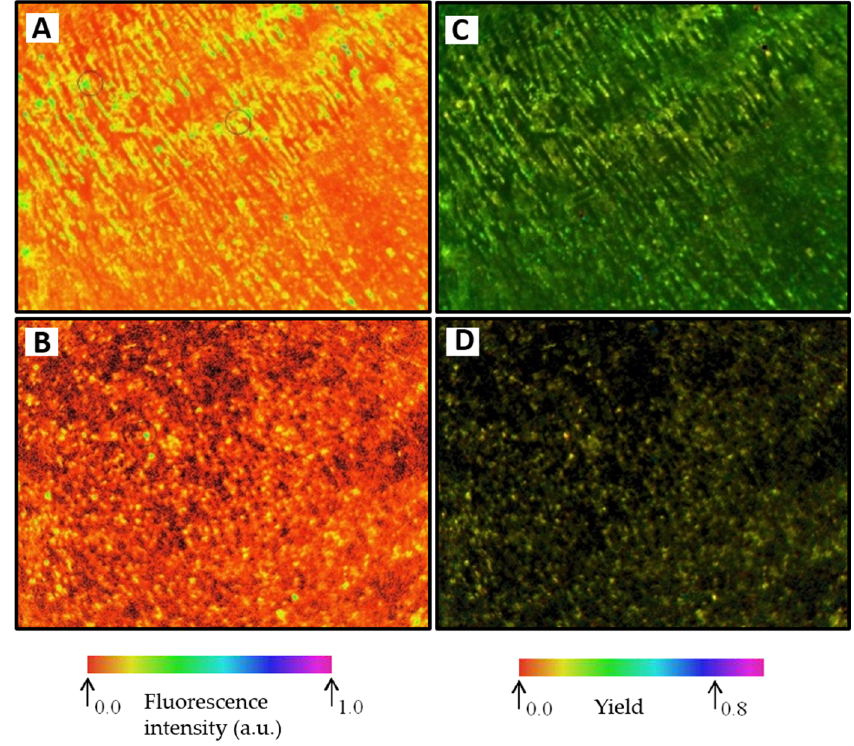
Figure 5. Examples of in situ fluorescence images of F ( A , B ) and Φ PSII_max ( C , D ), comparing chloro- phyll distribution and activity from base of ice cores on Day 73 before snowmelt ( A , C ) and Day 78 after snowmelt ( B , D ). The false colours indicate relative fluorescence intensity of F and Φ PSII_max as per the corresponding scales, and all images were taken at the same instrument measuring light and gain settings. All images are 30 × 23 mm.